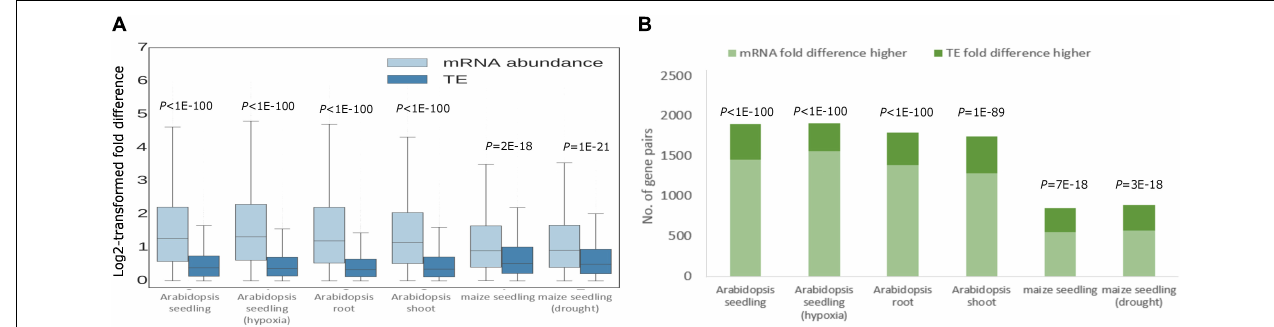
FIGURE 2 | Relative contributions of transcriptional and translational regulation to RF abundance divergence of WGD duplicates. (A) Log2-transformed fold differences in mRNA abundance and TE between WGD paralogs. Boxes extend from the first quartile (Q1) to the third quartile (Q3). The median is shown by a line inside the box. Whiskers extend to ± 1.5 interquartile range (IQR). P -values derived from the Wilcoxon signed-rank test are shown. (B) Numbers of WGD duplicate pairs with higher fold difference in mRNA abundance than TE and with higher fold difference in TE than mRNA abundance. P -values derived from the binomial test are